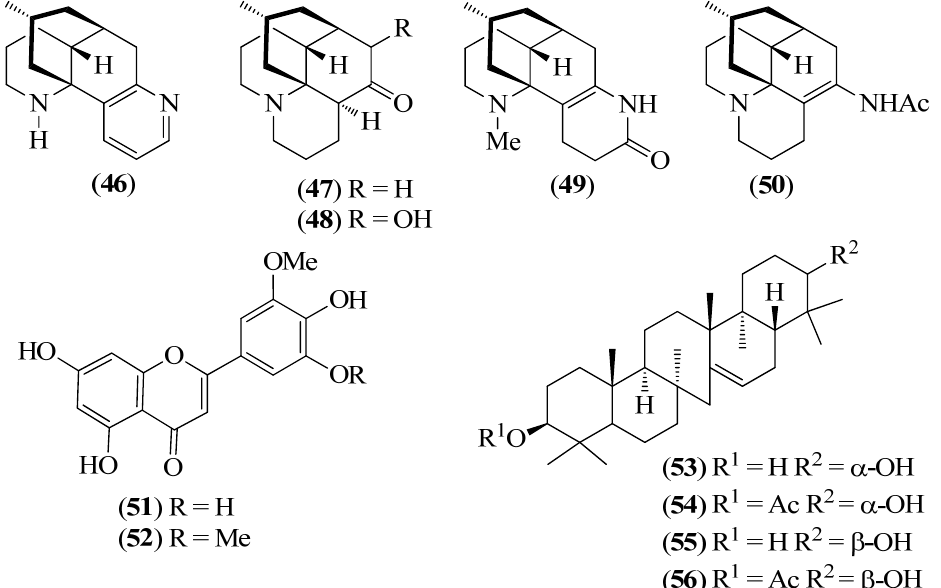
Figure 8. Structures of compounds 46 – 50 from Huperzia compacta , H. columnaris , and H. tetragona ; 51 and 52 from H. brevifolia and H. espinosana ; and 53 – 56 from H. crassa .